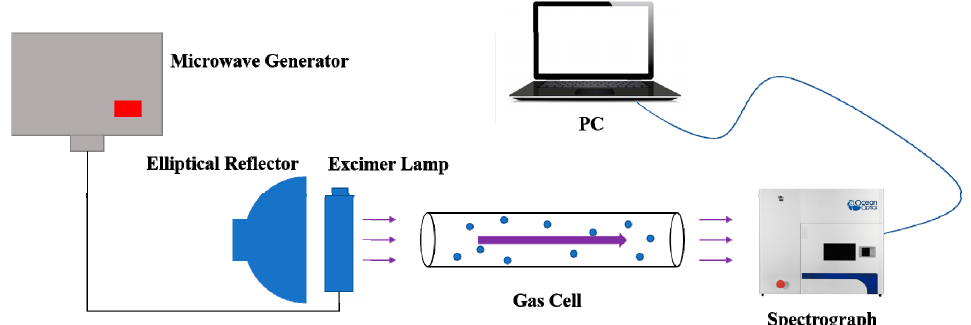
Figure 3. Schematic diagram of the detection system.